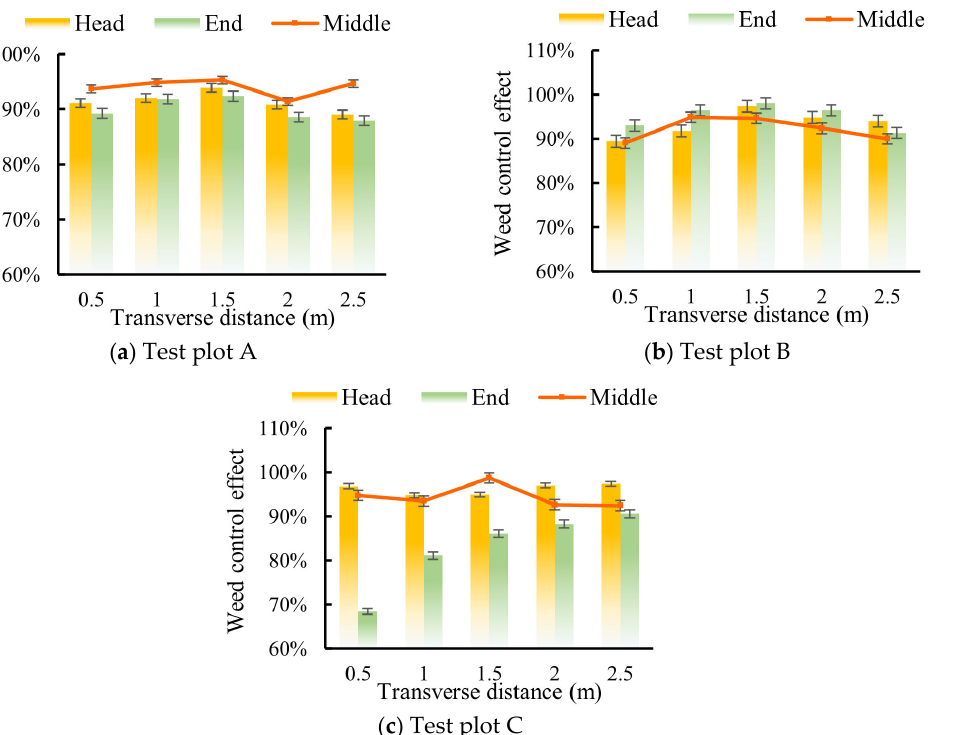
Figure 7. Weed control effect at the sampling points in the test plots. The data are the average of the three observations. The error bar is the standard error of the observations. After the significance analysis, the intergroup data had significant differences ( p < 0.05), while the intragroup data had no significant differences ( p ˃ 0.05).